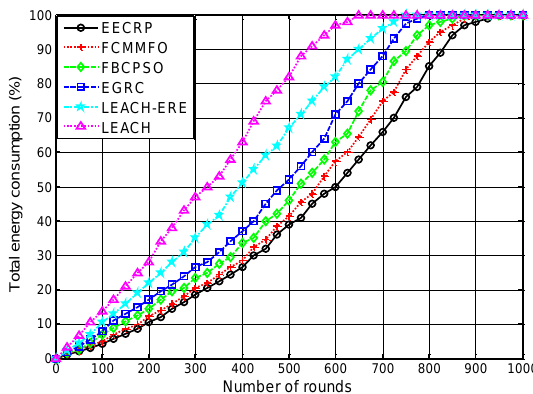
Figure 11. The total energy consumption of the network versus the number of rounds.